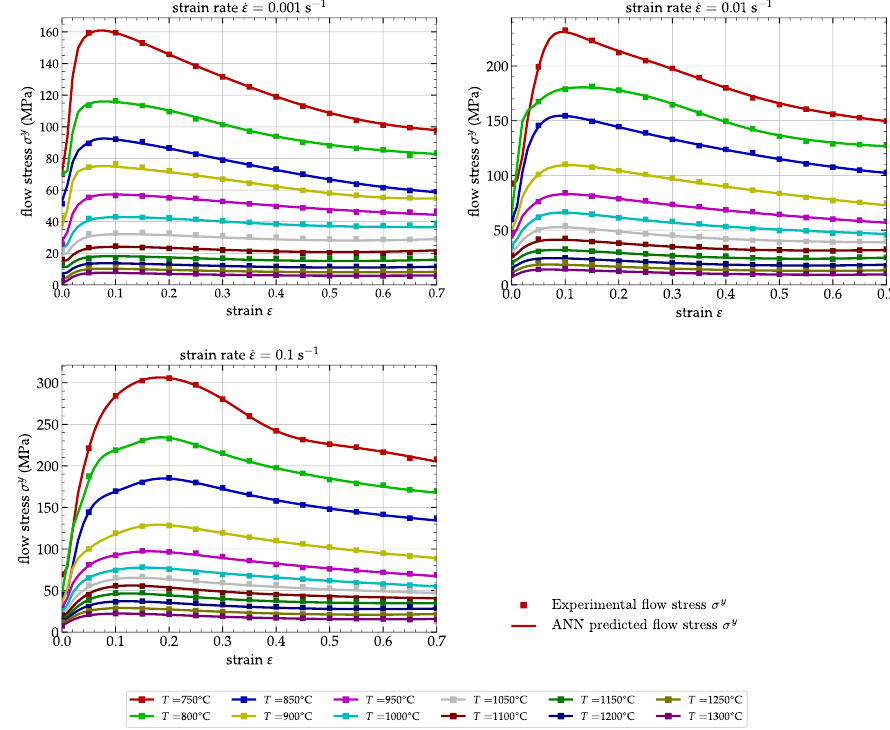
Figure 5. Comparison of the flow stress σ y predicted by the 3-15-7-1 ANN (continuous line) and the experimental data for the GCr15 (square